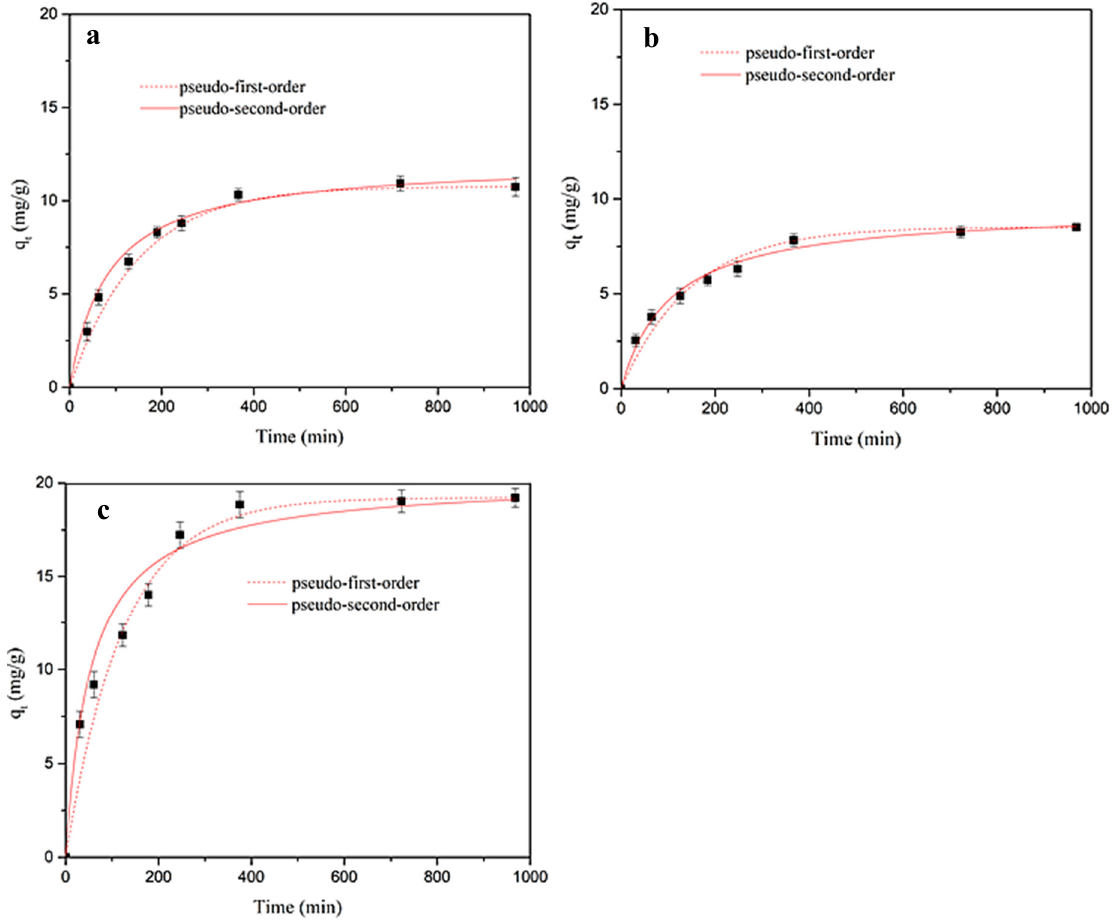
Figure 6. Experimental kinetic results together with pseudo-first- and pseudo-second-order model fittings for the adsorption of sulfamethoxazole (SMX) onto MY ( a ), MY@NIPs ( b ), and MY@MIPs ( c ) in ultrapure water.